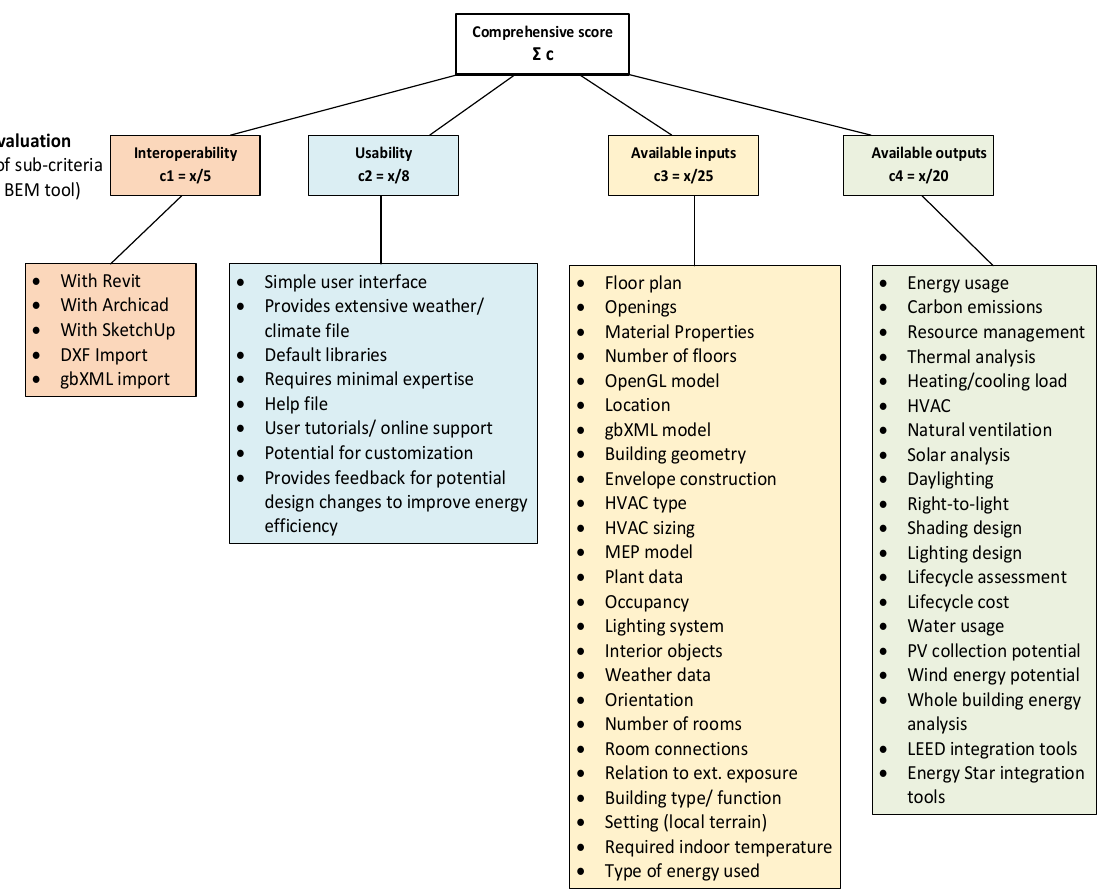
Figure 1. Initial evaluation scoring system with criteria and